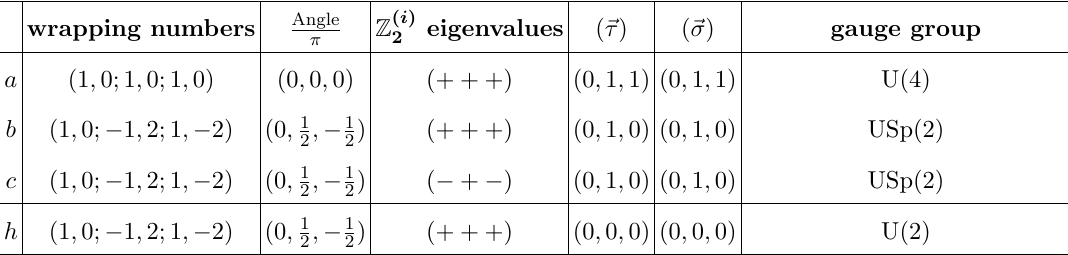
Table 23 . Pati-Salam model, prototype II, on the T 6 = ( Z 2 (cid:2) Z 6 (cid:2) (cid:10) R ) orientifold with discrete torsion. The three-cycles wrapped by D6-branes f a; b; c g are identical to those of the L-R symmetric models in table 18. Moreover, the ‘hidden’ brane h of this PS II model wraps the same three-cycle as h 1 of the L-R symmetric II